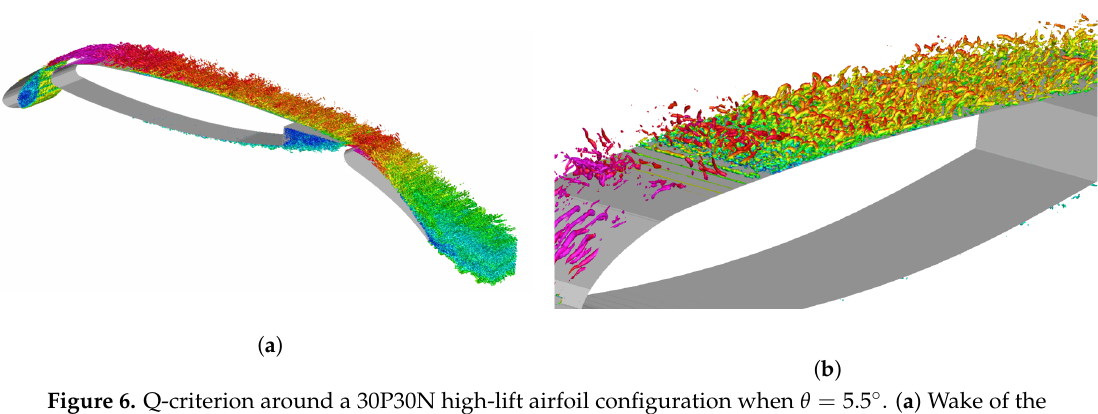
Figure 6. Q-criterion around a 30P30N high-lift airfoil configuration when θ = 5.5 ◦ . ( a ) Wake of the slat; ( b ) Vortices of the outer layer of the turbulent boundary layer on the suction side of the main